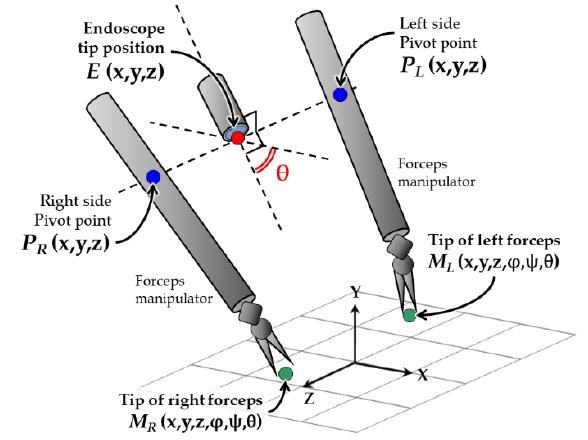
Figure 2. Experimental conditions of the virtual environment.